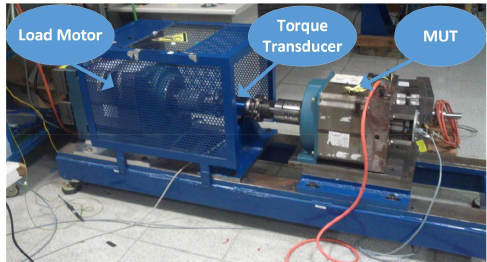
Figure 14. Picture of the test bench consisting of the load motor, the motor under test (MUT), and the torque